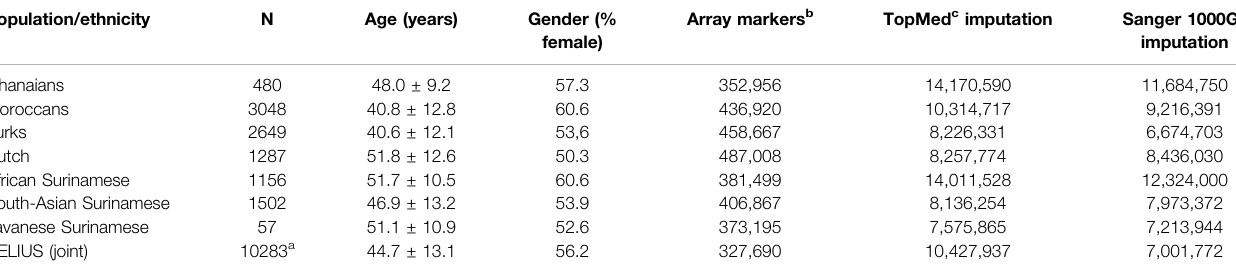
TABLE 1 | HELIUS study cohort overview of genotyped participants with number of markers genotyped and